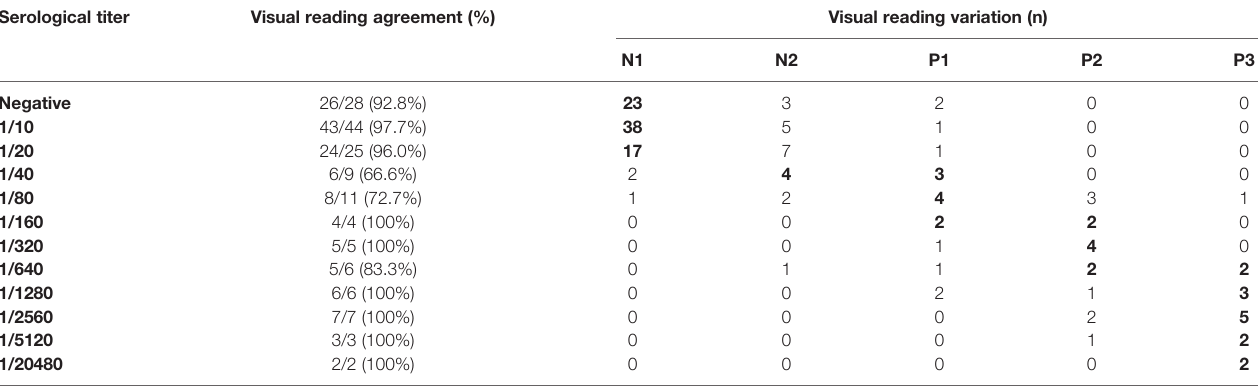
TABLE 2 | Relationship of agreement between visual reading according to serological titers given by IFAT and Chagas rapid test positive P1, P2 and P3 and negative N1 and N2, response patterns. Serological titer Visual reading agreement